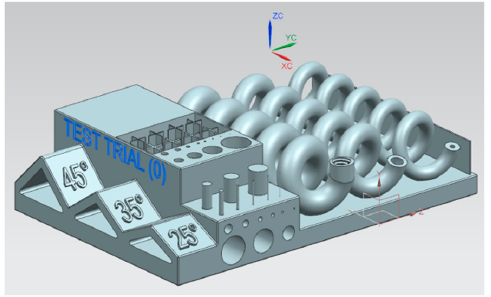
Figure 3. Artifact with spiral on benchmarking [27].